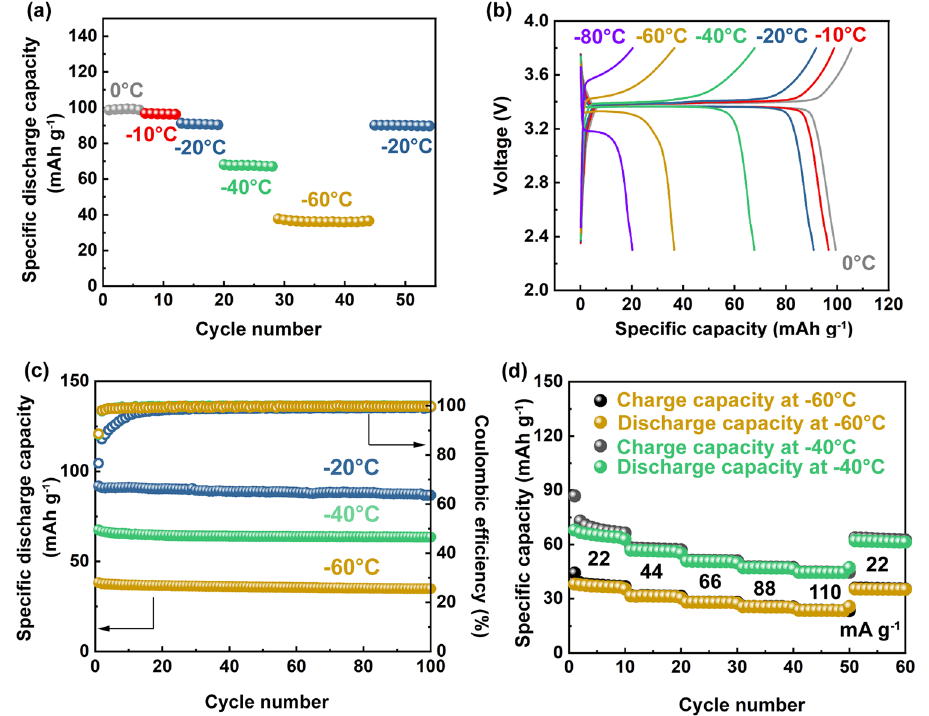
Fig. 6 | Electrochemical energy storage performance of Na||Na 3 V 2 (PO 4 ) 3 coin cells using the 0.5M NaOTf-DEGDME/DOL (2:8) electrolyte solution at low temperatures.a Temperature-dependentgalvanostaticcyclingofcellsat22mAg − 1 (equivalentto0.2C,1C=110mAg − 1 ,basedontheactivematerialNa 3 V 2 (PO 4 ) 3 )down to − 60°C with voltage cutoffs of 2.3 and 3.8V. Note that the duration of cycling at